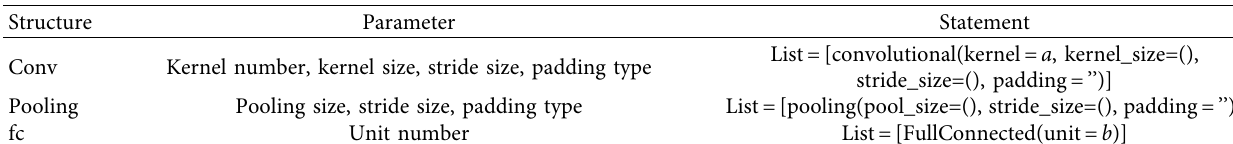
Table 1: Storage content of one list